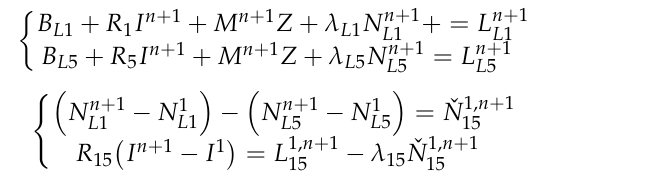
Table 11. Final fixing rate of narrow-lane ambiguity resolution (%). Success Undecided Misfixed